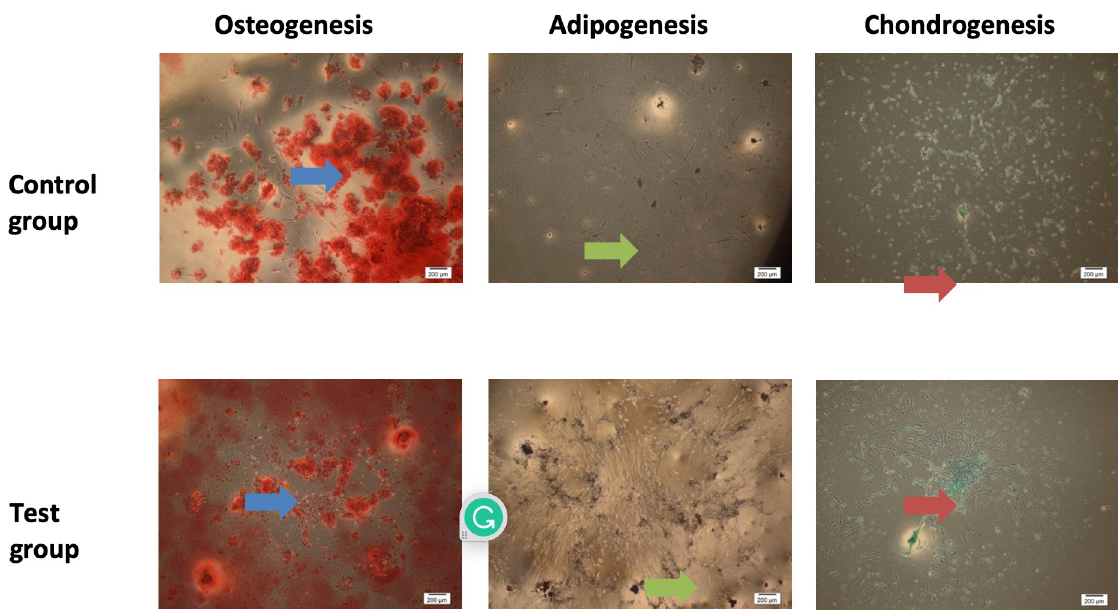
Fig 7. Multilineage differentiation assays (osteogenic, adipogenic, and chondrogenic) of the cells from the control and test groups at 5x magnification (2 mm = 200 μ m) (blue arrow: Calcium stained in red; green arrow: Lipid droplets stained in red; red arrow: Proteoglycan stained in